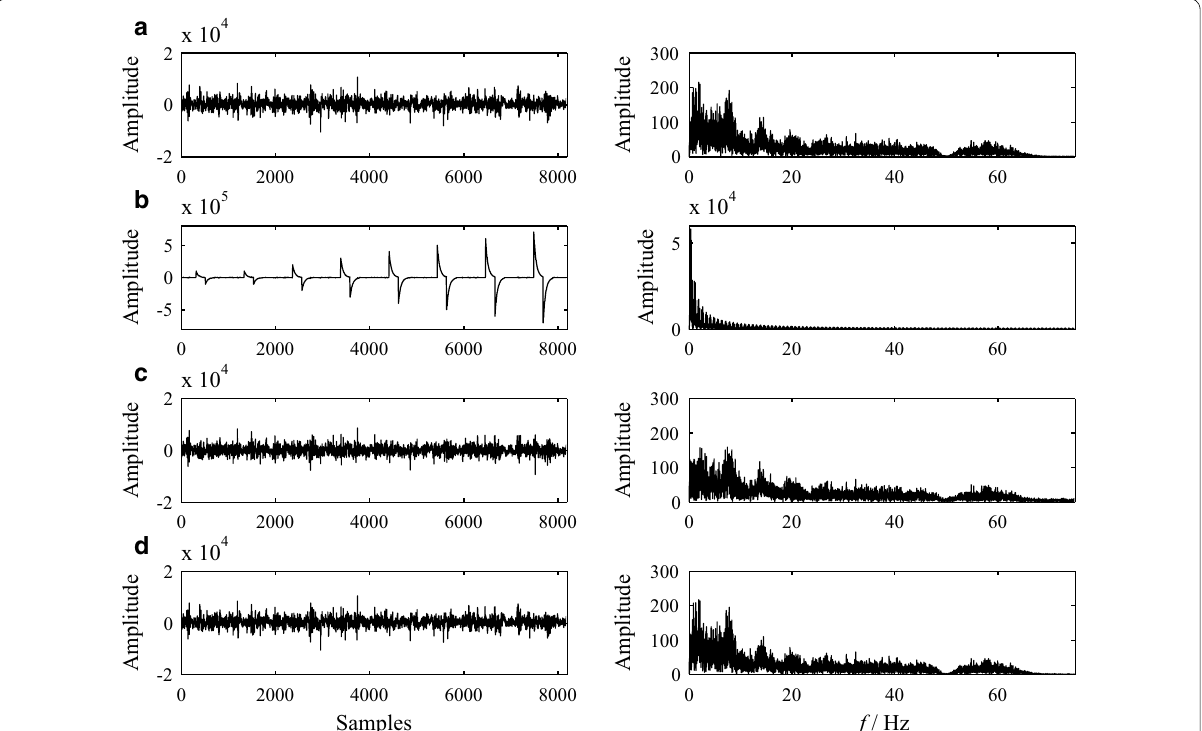
Fig. 2 Results of the charge–discharge-like noise processing. a Original noise-free MT signal; b synthetic noisy signal; c de-noised by pulse dictionary-based method (PSO-PD); d de-noised by ISISC. The left panels are time domain waveforms and the right panels are their spectra